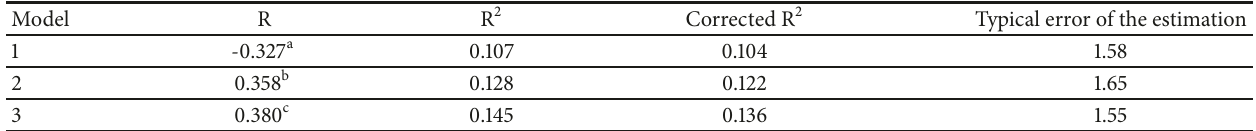
Table 4: Linear regression model of significant variables that best explain the psychiatric comorbidity in 394 primary care patients with depression, Maule region, Chile,